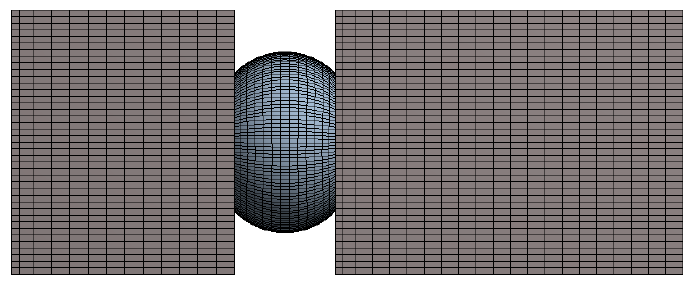
Figure 3. Global finite element model.